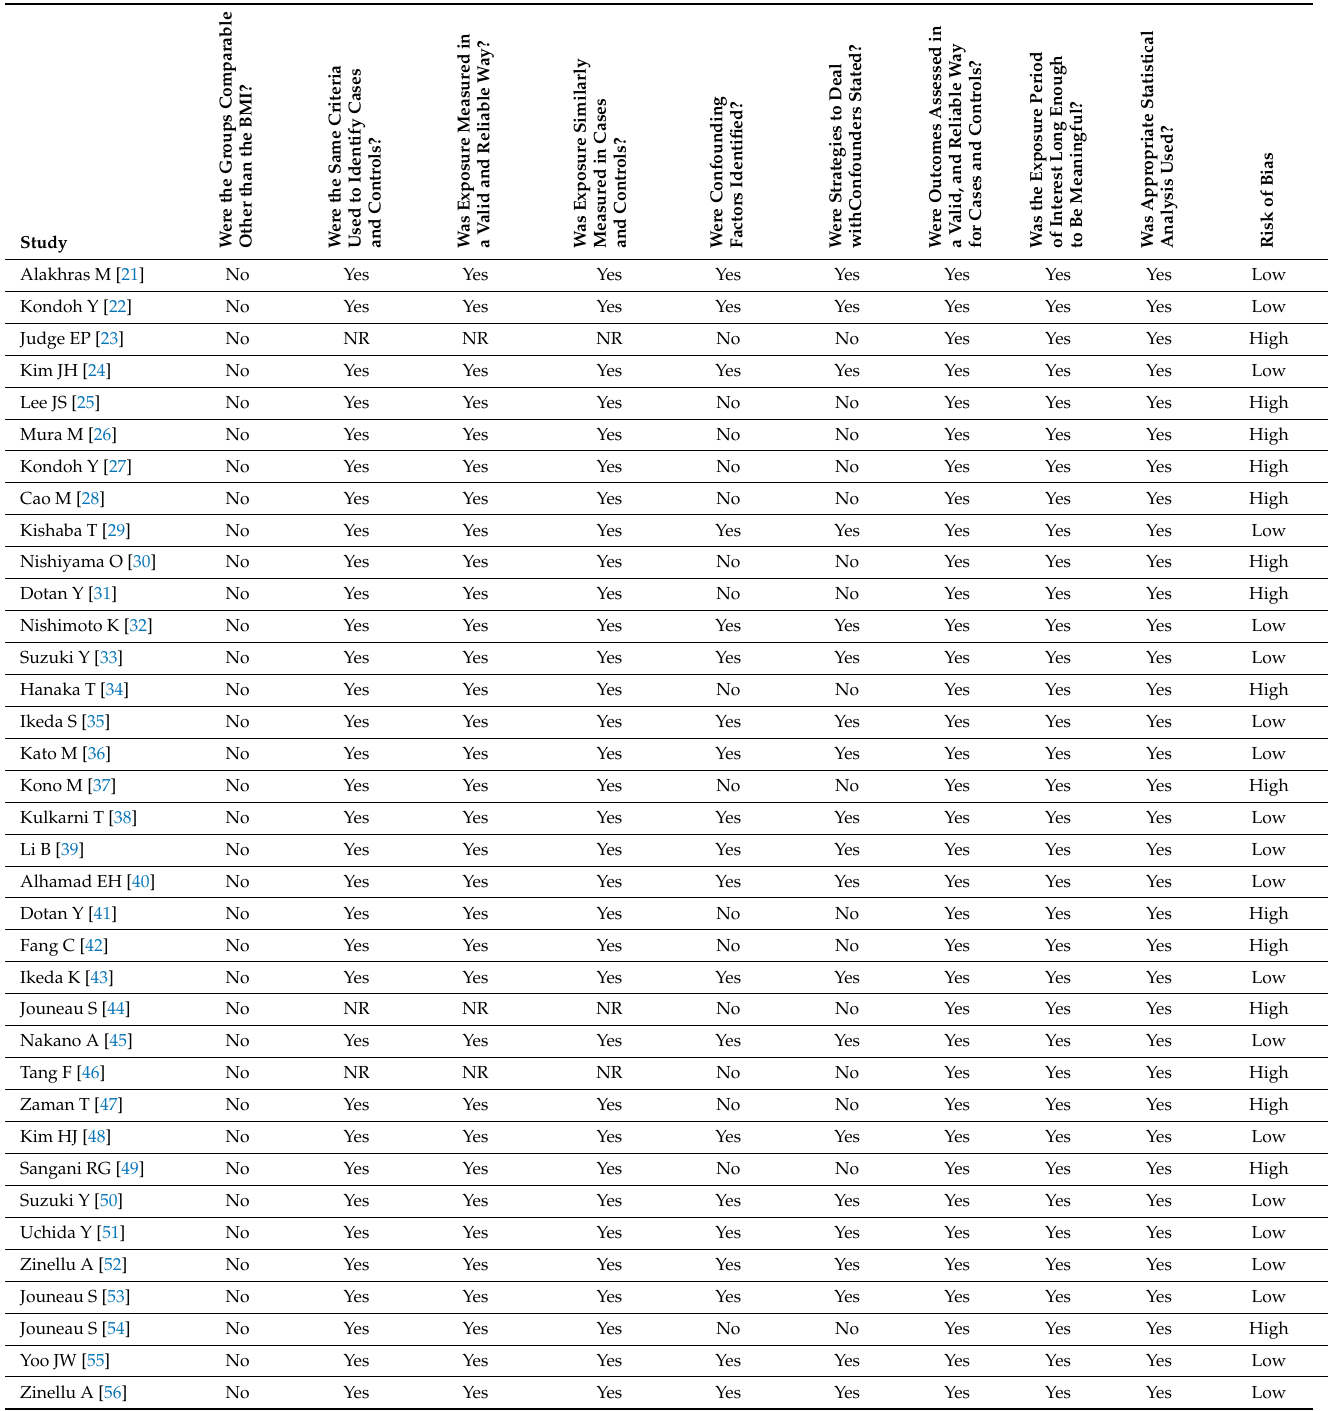
Table 2. The Joanna Briggs Institute critical appraisal